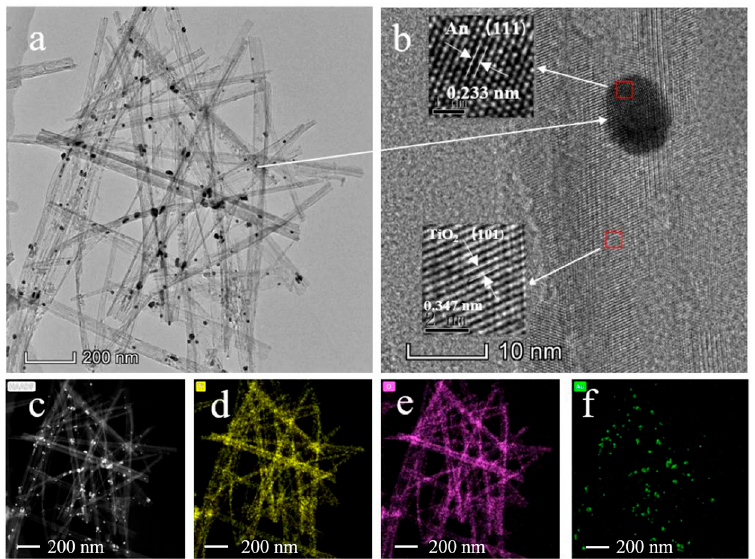
Figure 2. ( a ) TEM, ( b ) HRTEM, and ( c ) EDS mapping, ( d ) Ti, ( e ) O, ( f ) Au images of 0.5 wt.% Au/TiO 2 NTs.